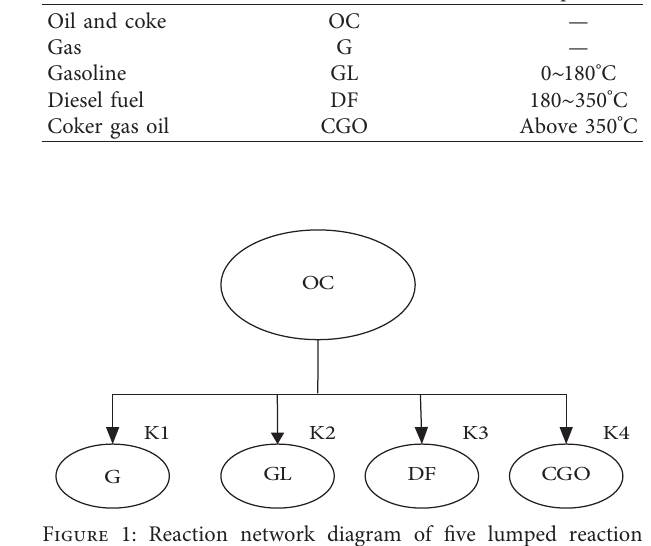
Figure 1: Reaction network diagram of five lumped reaction kinetics.